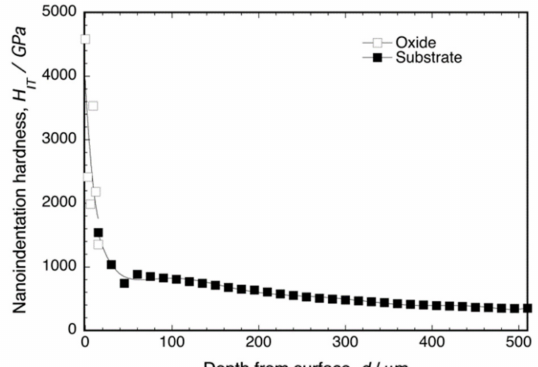
Figure 5. Nanoindentation hardness of oxidized Ti–29Nb–13Ta–4.6Zr at the interface. The oxidation conditions at 1273 K for 1.8 ks in air.